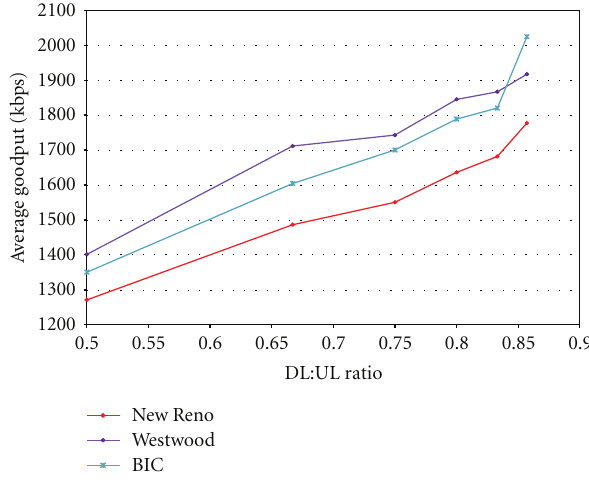
Figure 10: Goodput versus PER for the Scenario 3 (DL:UL = 3:1).